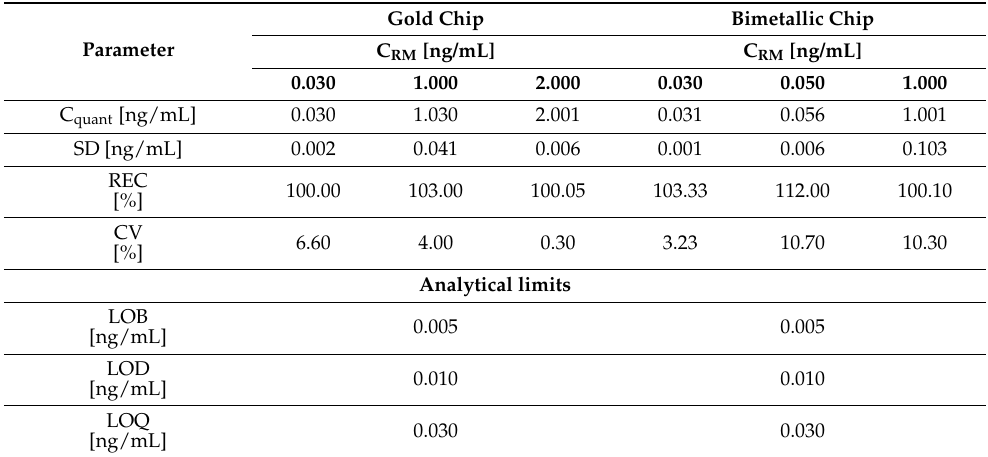
Table 3. Validation parameters of the developed methods.